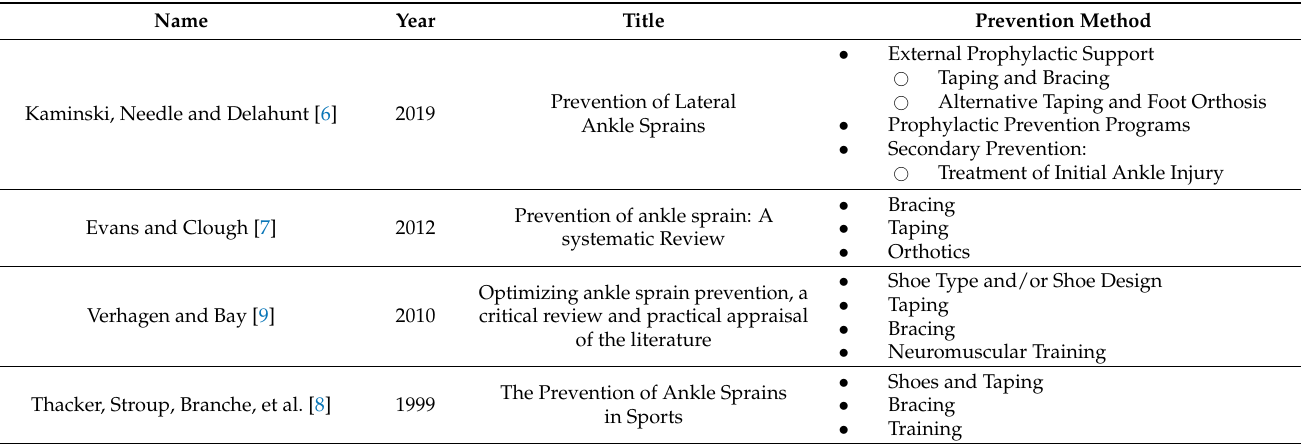
Table 2. List of Systematic Review of Academic Literature on Ankle Sprain